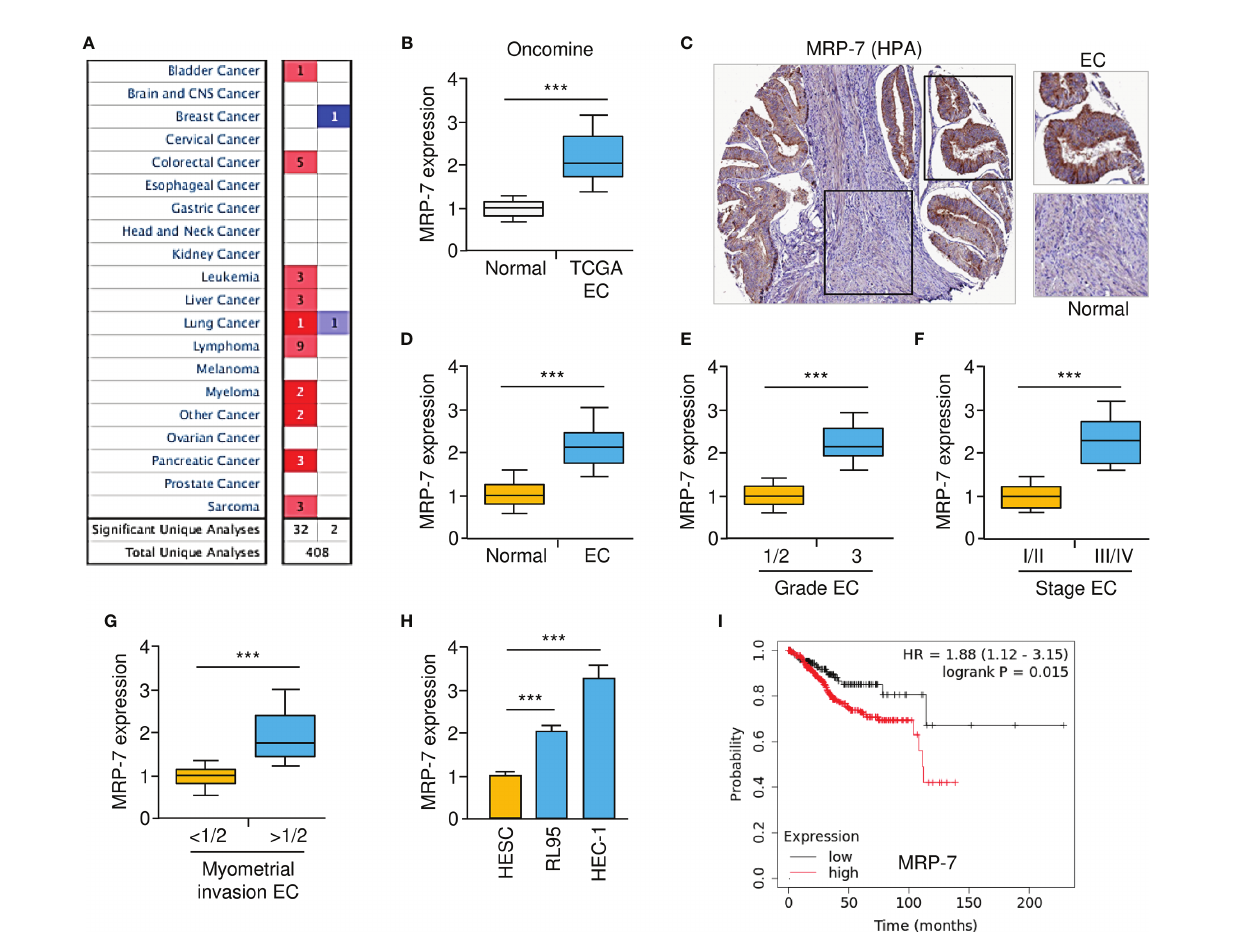
FIGURE 1 | Gain of MRP-7 Expression Correlates with EC Progression. (A) The Oncomine database was used to compare MRP-7 mRNA expression between different tumor and normal tissues. Red denotes an increase in MRP-7 expression, while blue denotes a reduction in MRP-7 expression. (B) MRP-7 mRNA expression in TCGA EC tissues compared to normal tissues (Oncomine database). (C) Immunohistochemistry images of MRP-7 staining using tissue microarray tissue sections (HPA database). (D) The mRNA levels of MRP-7 in EC and normal tissues were examined using qRT-PCR experiments. (E – G) The expression of MRP-7 mRNA was considerably higher in EC patients with a high tumor grade (E) , late-stage disease (F) , or deeper myometrial invasion (G) . (H) MRP-7 mRNA expression is substantially higher in EC cells than in normal HESC cells. (I) KM plotter database was used to analyze the association between MRP-7 expression and the overall survival of EC patients. *** P <